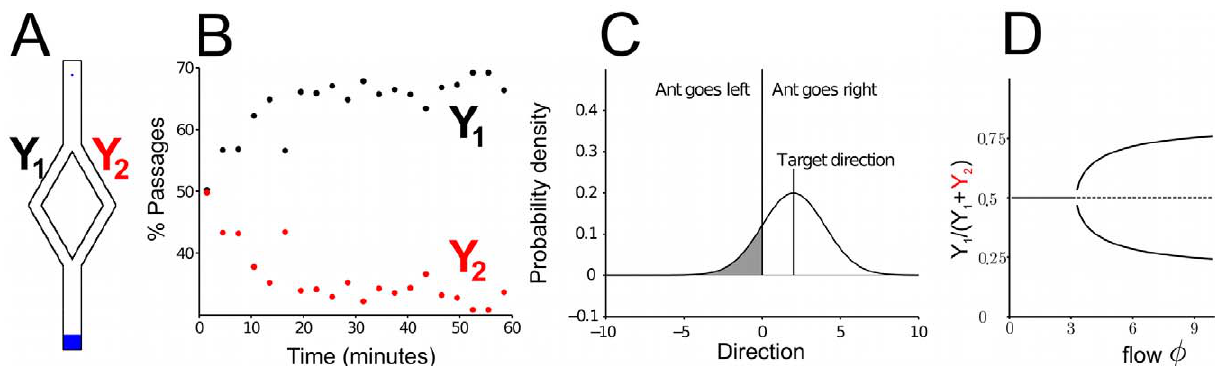
Figure 8. Simulation and analytical results implementing Weber’s Law type response to pheromone in a binary bridge. A . Illustrative drawing of the simulation domain; the blue dot near the top of maze represents the nest, while the large blue region at the bottom is the food source. B . Percentages of simulated ants on each branch of the maze at different times in one run of simulation (each point represent the average over three minutes of simulation). C. Schema providing an intuitive explanation of equation 8. The target direction of one ant depends linearly on ( LR ) . The probability for the ant to choose the left branch depends on the target direction and the directional noise. More precisely, if we assume that the branching point between left and right branch is at direction zero, the probability that the ant chooses the left branch is given by the integral of the curve in panel B from { ? to 0. D. Bifurcation diagram for the density of ants on one branch of the bridge ( Y 1 ) as a function of the total flow of ants in the setup.